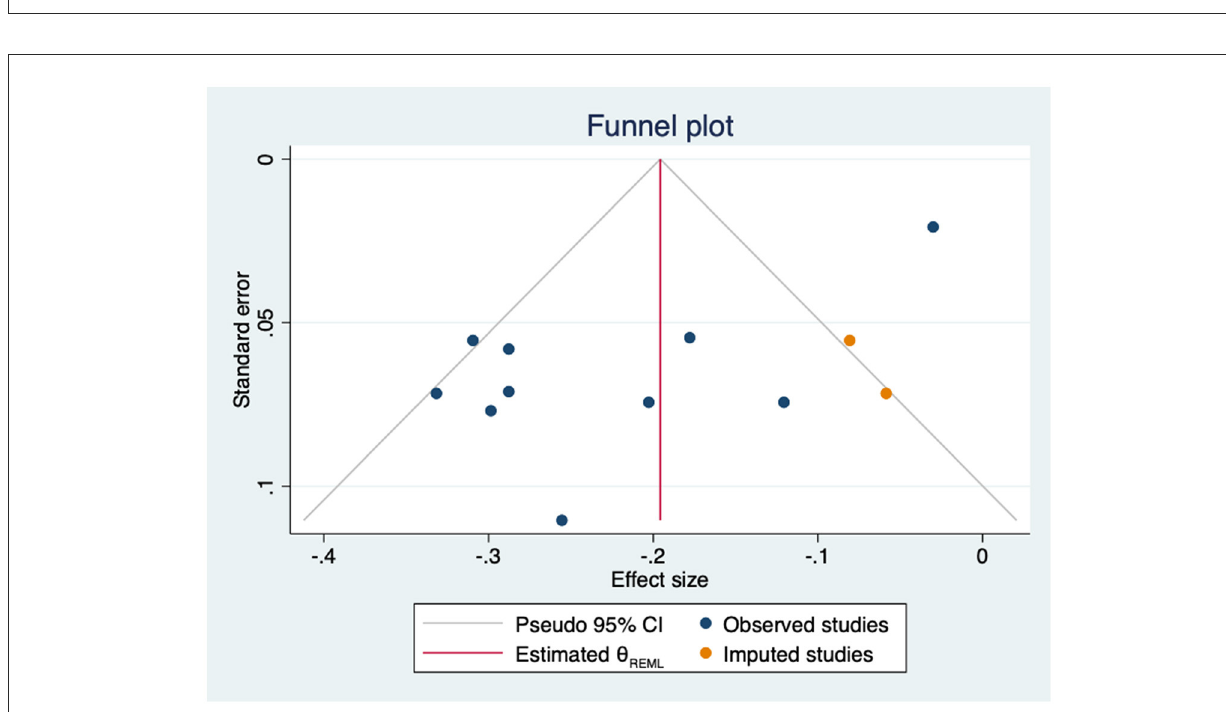
FIGURE4 Funnel plot with trim-and-fill imputations for the association between empowerment and anxiety.